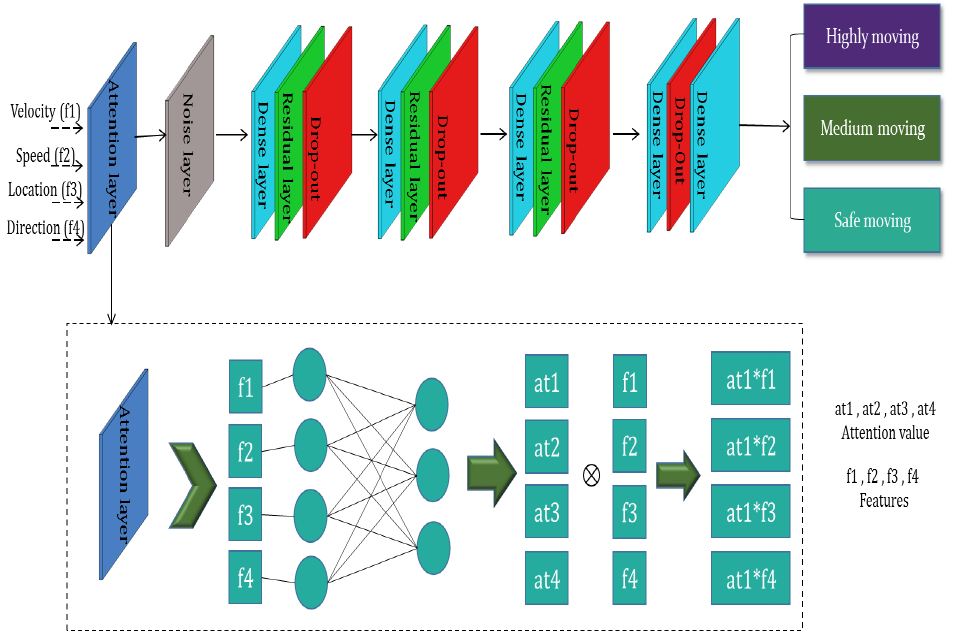
Figure 2. AttresNet Model.